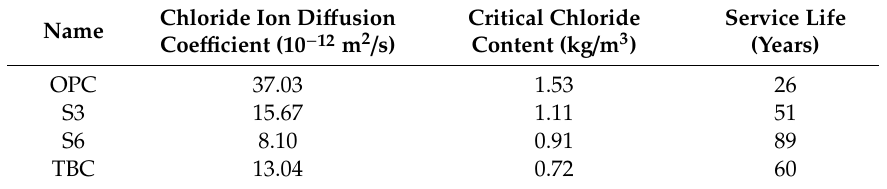
Table 10. Service life of the RC structure by binder type with improved critical chloride content.